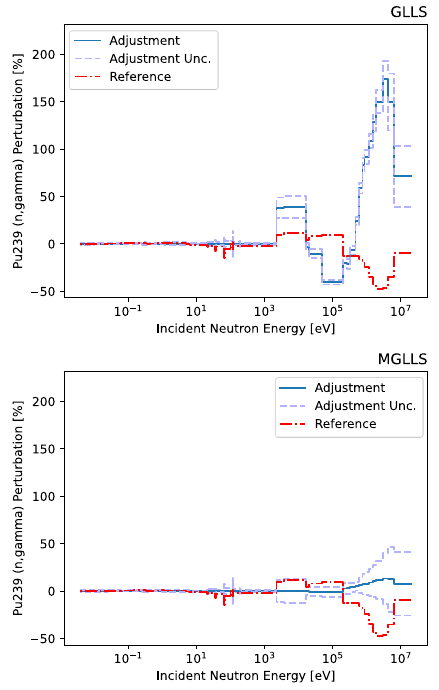
Fig. 7 Comparison of adjusted nuclear data